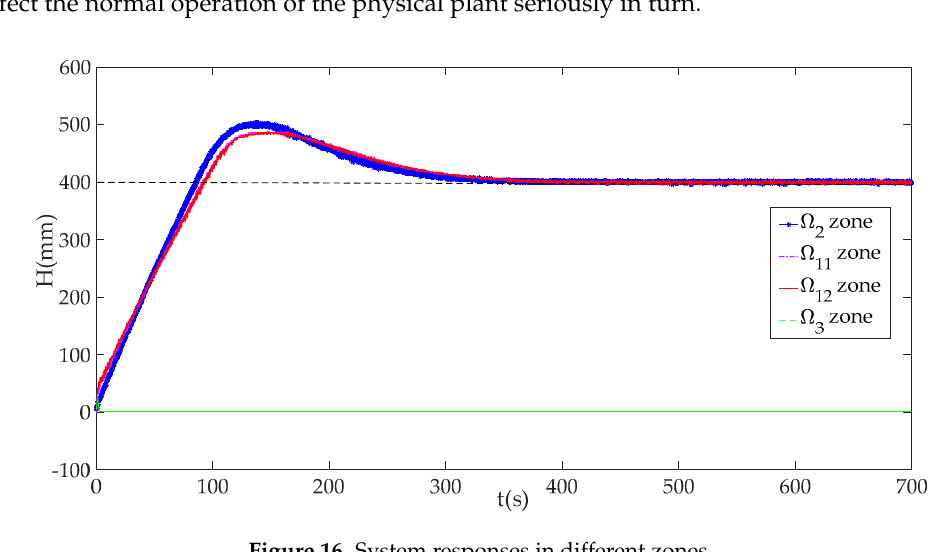
Figure 16. System responses in different zones.